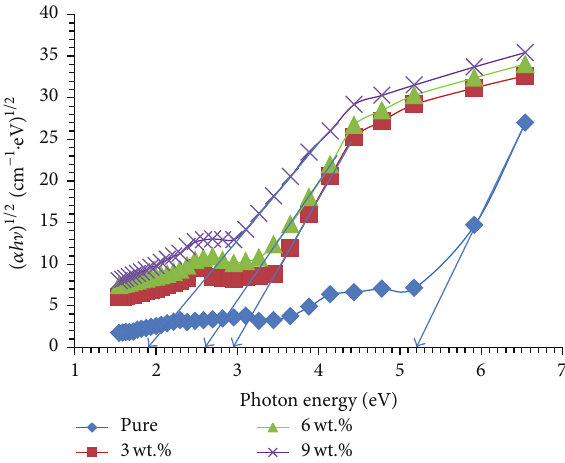
Figure 8: (𝛼ℎ𝜐) 1/2 versus photon energy of PVAc/0, PVAc/3, PVAc/6, and PVAc/9 wt.% of [Co(NH 3 ) 5 Cl]Cl 2 composites.